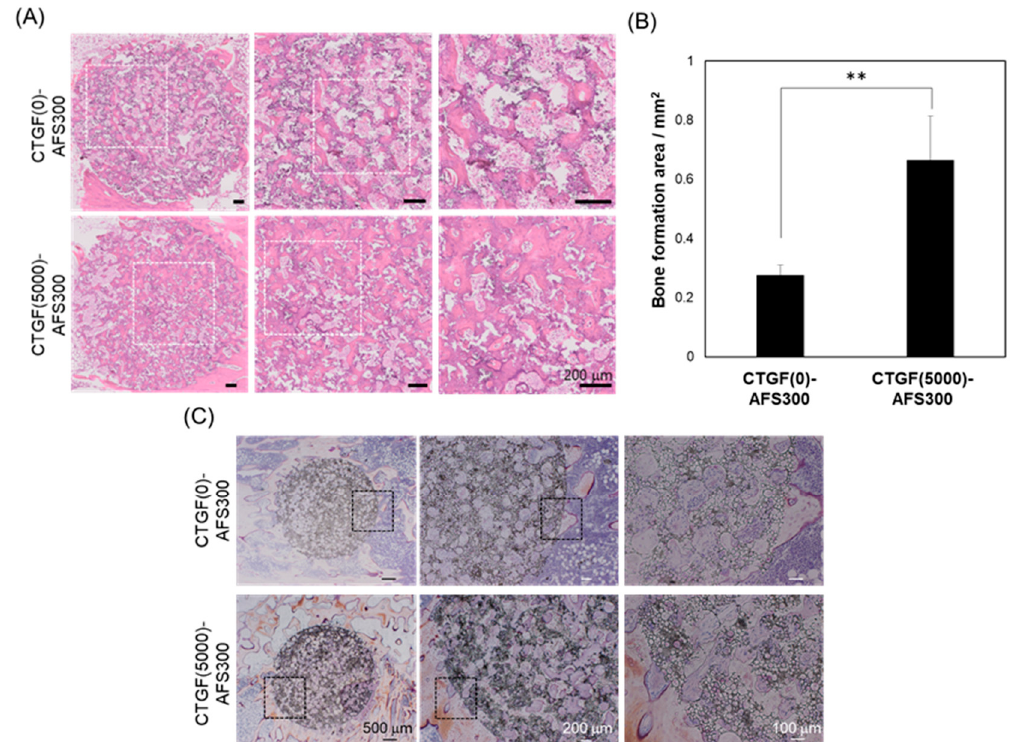
Figure 8. Photomicrographs of histological sections stained with H&E and Villanueva bone staining in CTGF(0)-AFS300 and CTGF(5000)-AFS300, eight weeks after the operation. ( A ) In contrast to the CTGF(0)-AFS300, CTGF(5000)-AFS300 contained numerous cells. New bone formation was observed in CTGF-loaded AFS. Scale bars indicate 200 μ m, respectively. ( B ) The newly-formed bone of CTGF(0)-AFS300 or CTGF(5000)-AFS300 were measured by NDP view software. Bar graphs represent means ± SD. ** Significantly different ( p < 0.01) from the value with CTGF-HAp(0). ( C ) Upper panels showed CTGF(0)-AFS300 and lower panels represent CTGF(5000)-AFS300. Center panels show high magnification of the square area in left panels. Right panels represent high magnification of the square area in center panels. Scale bars indicate 500, 200, 100 μ m, respectively.